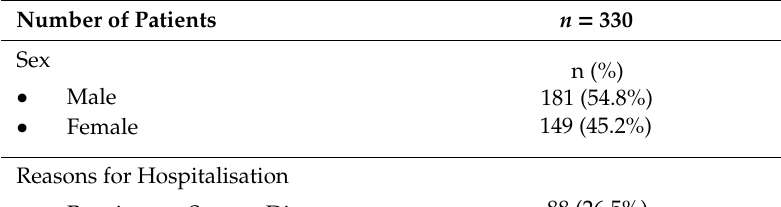
Table 1. Demographic characteristics of